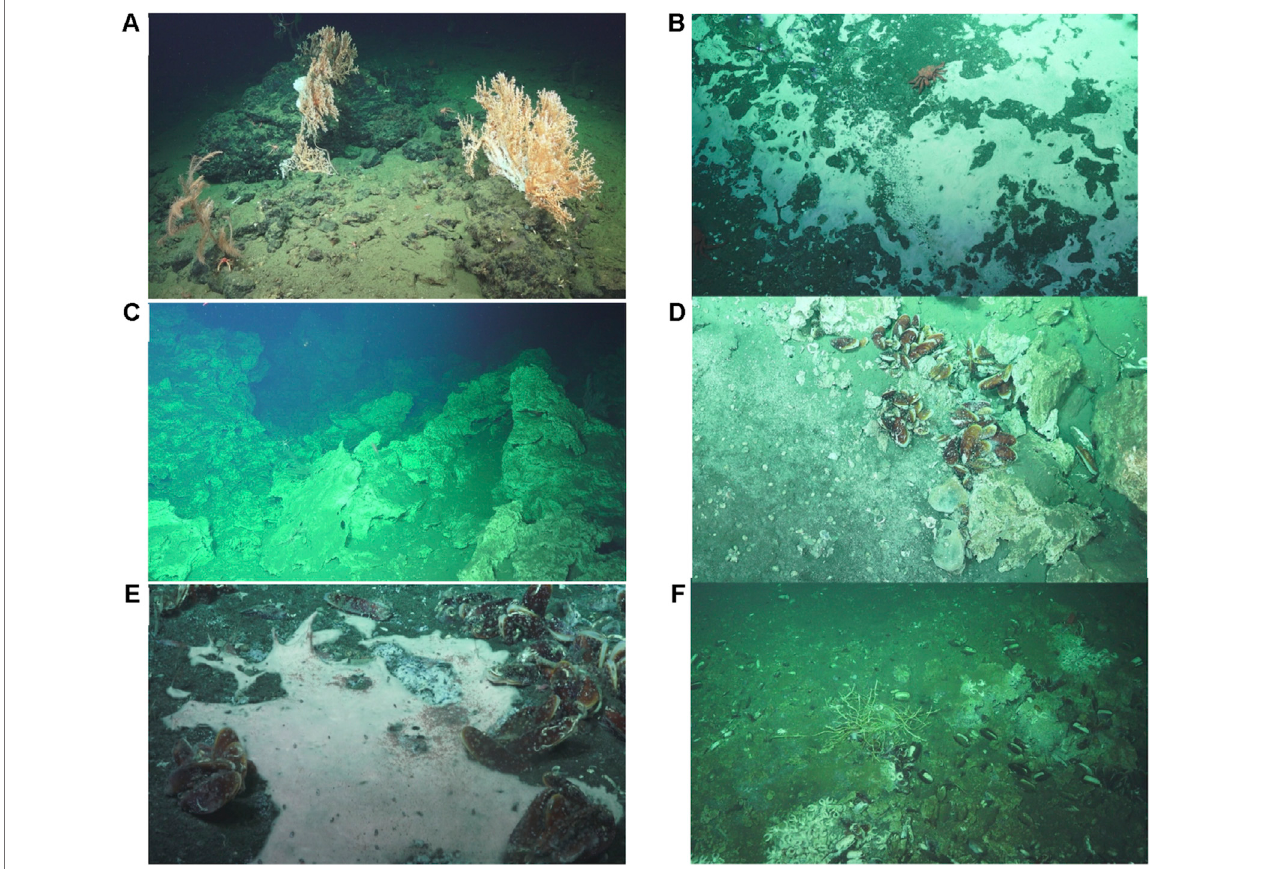
FIGURE 3| Seep observations photographed byROV. (A) Coralsaf fi xed to carbonate crust outcrops, Dive SO204 (SA4: Jaco); (B) Methane bubble stream rising out of edge of microbial mat, Dive SO206 (SA1: Pacuare); (C) Jagged carbonate crust outcrops, Dive SO204 (SA4: Jaco); (D) Clam colony nestled along edge of carbonate crust and adjacent thin microbial mat covered by snails, Dive SO204 (SA4: Jaco); (E) Thick microbial mat fringed by clams, Dive SO210 (SA2: Savegre); (F) Tubewormsgrowingfromcarbonatecrustoutcropand fl ankedbyclams,DiveSO208(SA3:Mounds11/12).Speci fi cphotolocationsidenti fi edin Supplementary Materials